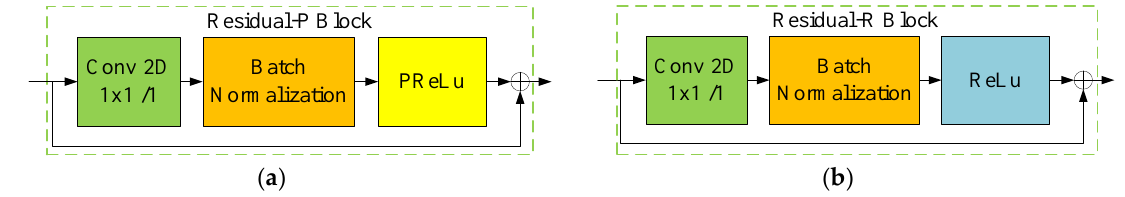
Figure 5. Comparison of the residual block used in ( a ) SurfNet and ( b ) the proposed SurfNetv2.